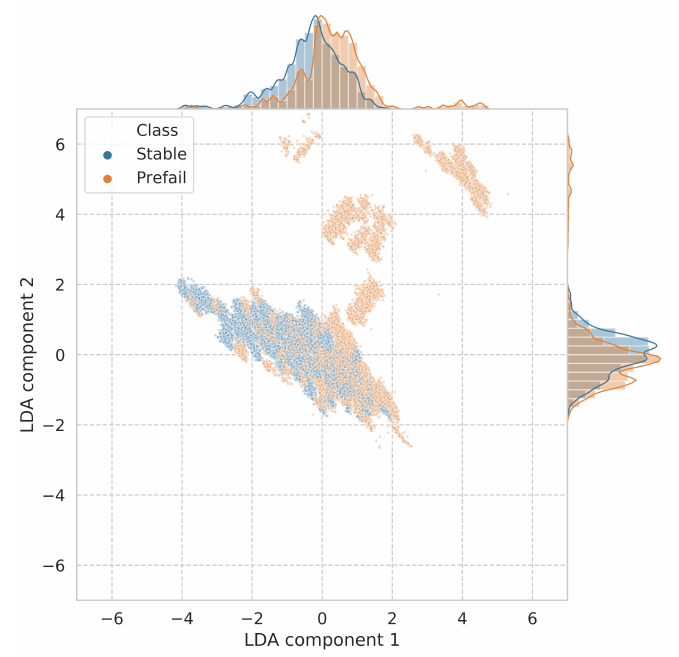
Figure 13. First two components of linear discriminant analysis showing prefail/stable condition separation including their